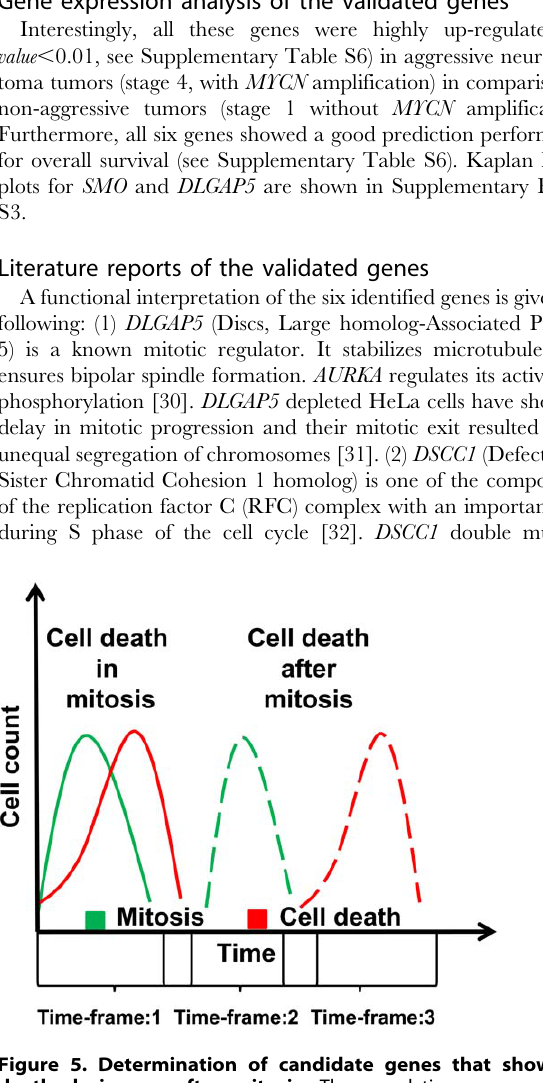
Figure 5. Determination of candidate genes that show cell death during or after mitosis. The population response to a knockdown was computed to identify the sequence of phenotype occurrence.